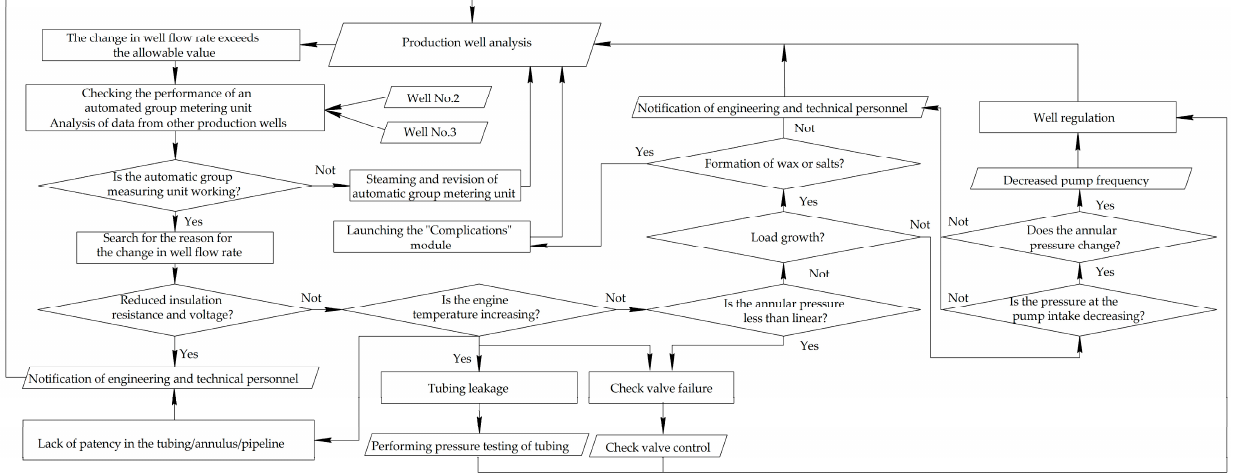
Figure 4. Algorithm for analyzing the cause of well flow rate deviation.